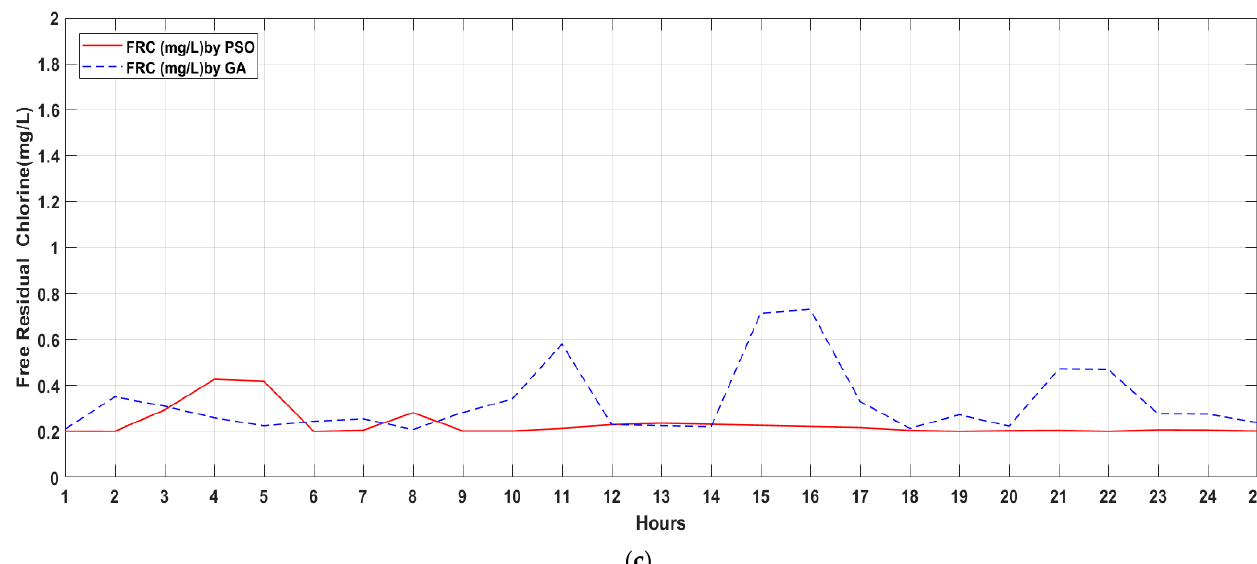
Figure 11. ( a ) FRC concentrations on the farthest modes from the initial distribution (node 30). Last day of simulation obtained for GA and PSO. ( b ) FRC concentrations on the farthest modes from the initial distribution (N = node 34). Last day of simulation obtained for GA and PSO. ( c ) FRC concentrations on the farthest modes from the initial distribution (node 36). Last day of simulation obtained for GA and PSO.